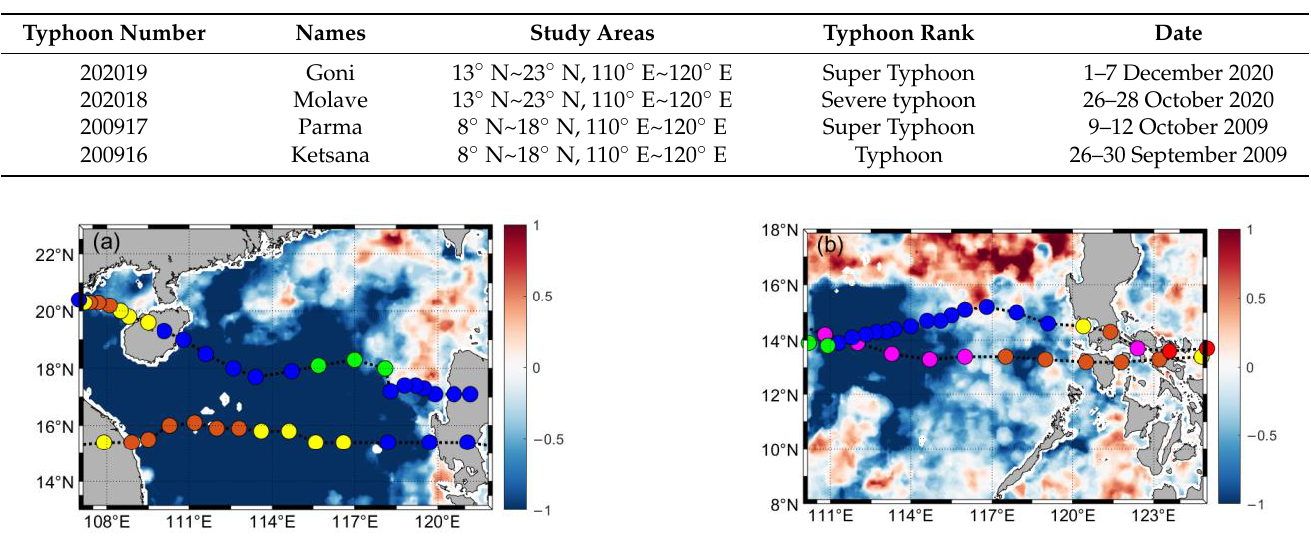
Figure 12. Typhoon tracks and intensities of successive typhoons ( a ) Ketsana and Parma, ( b ) Molave and Goni (background field represents the change in SST ( ◦ C) after the first typhoon) (The discs represent the locations of the typhoons and the color of each disc represents the intensity of the typhoons, following the color categorization in Figure 2a).